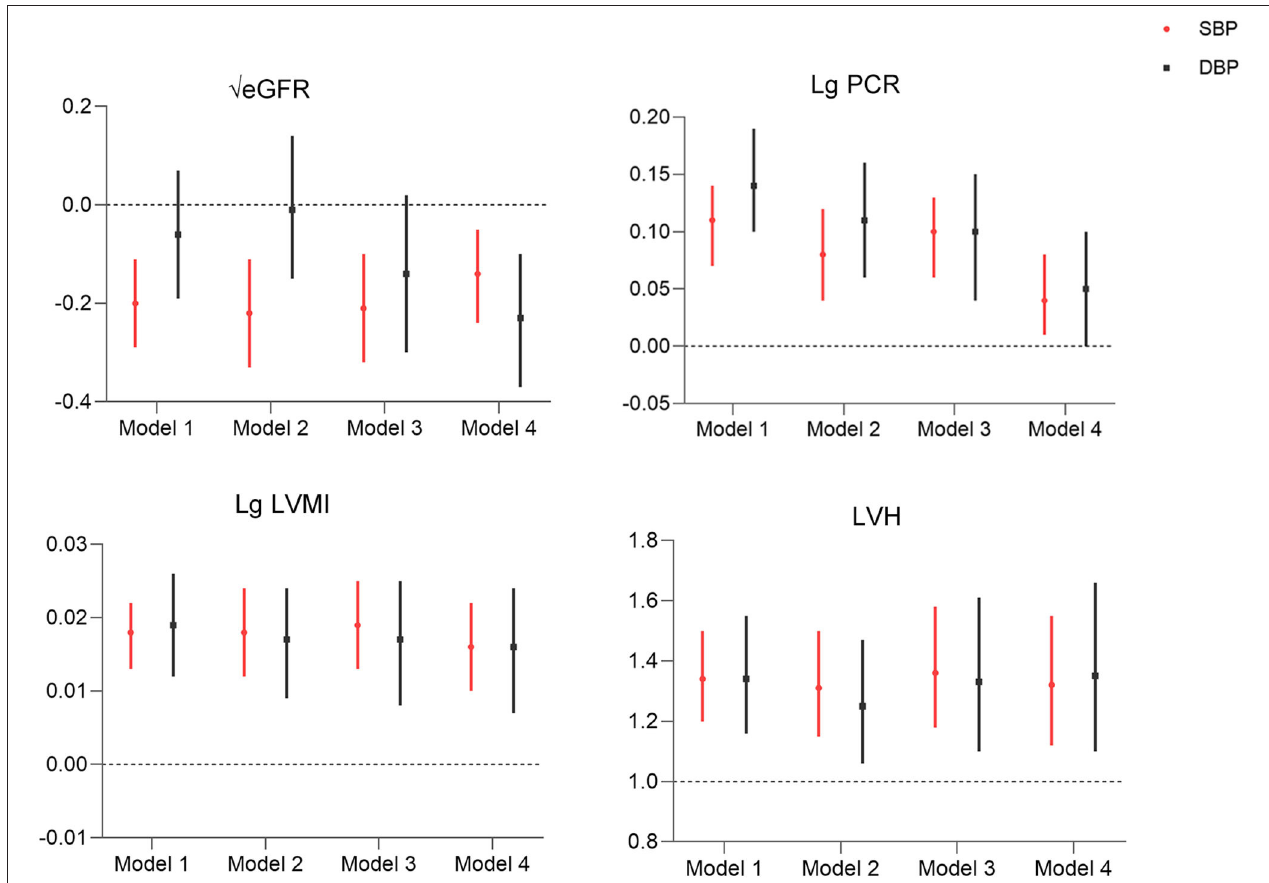
FIGURE 2 | Association of morning systolic blood pressure and diastolic blood pressure (per 10 mmHg) with target organ damage. Model 1: morning hypertension; model 2: model 1 nocturnal hypertension morning surge in blood pressure; model 3: model 2 age, sex, BMI, alcohol, smoking, CV history, DM; model 4: model + + + 3 hemoglobin, albumin, Na, k, TG, office BP control for eGFR; hemoglobin, albumin, Na, K, creatinine, uric acid, TG, office BP control for Lg LVMI, hemoglobin, + albumin, glucose, p*ca, creatinine, CHOL, HDL, LDL, office BP control for Lg PCR; hemoglobin, albumin, Creatinine, Na, K, TG, HDL, LDL, office BP control for LVH. LVMI, left ventricular mass index; PCR, protein–creatinine ratio; eGFR, estimated glomerular filtration rate; LVH, left ventricular